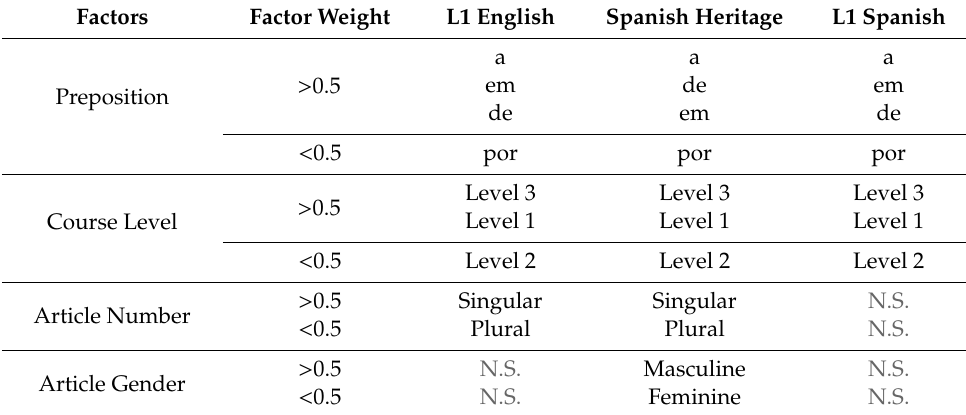
Table 12. The impact of preposition type and course level on the production of contractions among L3 Portuguese learners in order of probability factor weights (non-significant results are indicated with